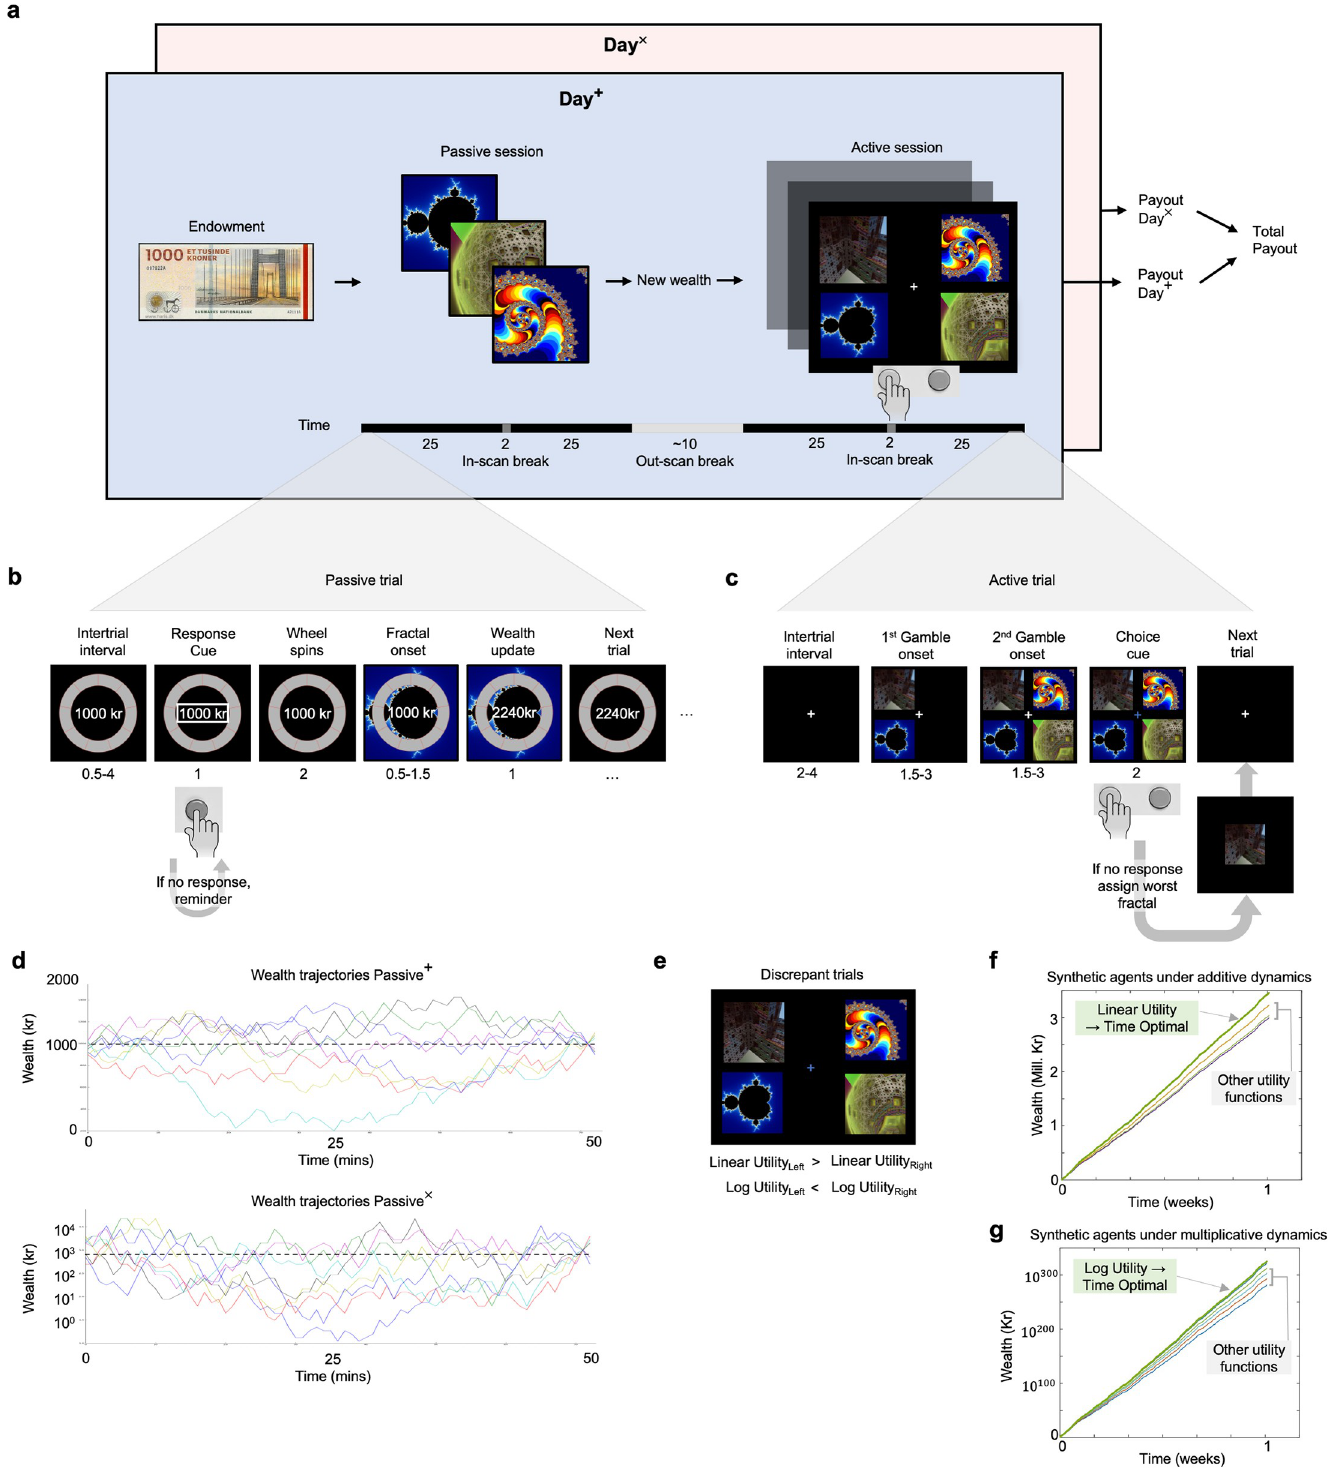
Fig 1. Experimental design and wealth trajectories. A , two-sheets (blue and pink) summarise the repeated protocol for both days, which only differ in the dynamics of wealth changes. Numbers indicate durations in minutes. Although three stimuli are shown for illustration, a total of 9 stimuli were used in each session. B , single trial from a passive session, where durations are in seconds and ranges depict a uniformly distributed temporal jitter. C , single trial from an active session. D , wealth trajectories in real time over the course of each passive session. The trajectory for Passive × is plotted on a log scale, appropriate to the multiplicative dynamics. Eight